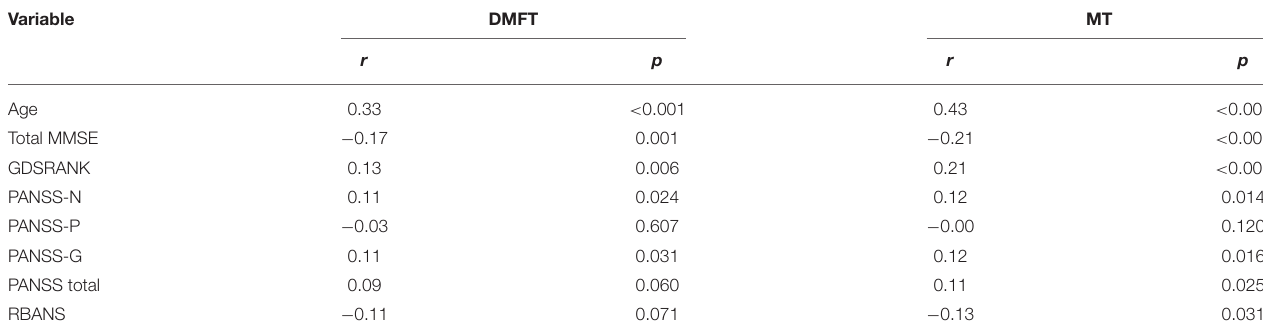
TABLE 3 | Correlations of DMFT and MT with cognition and mental